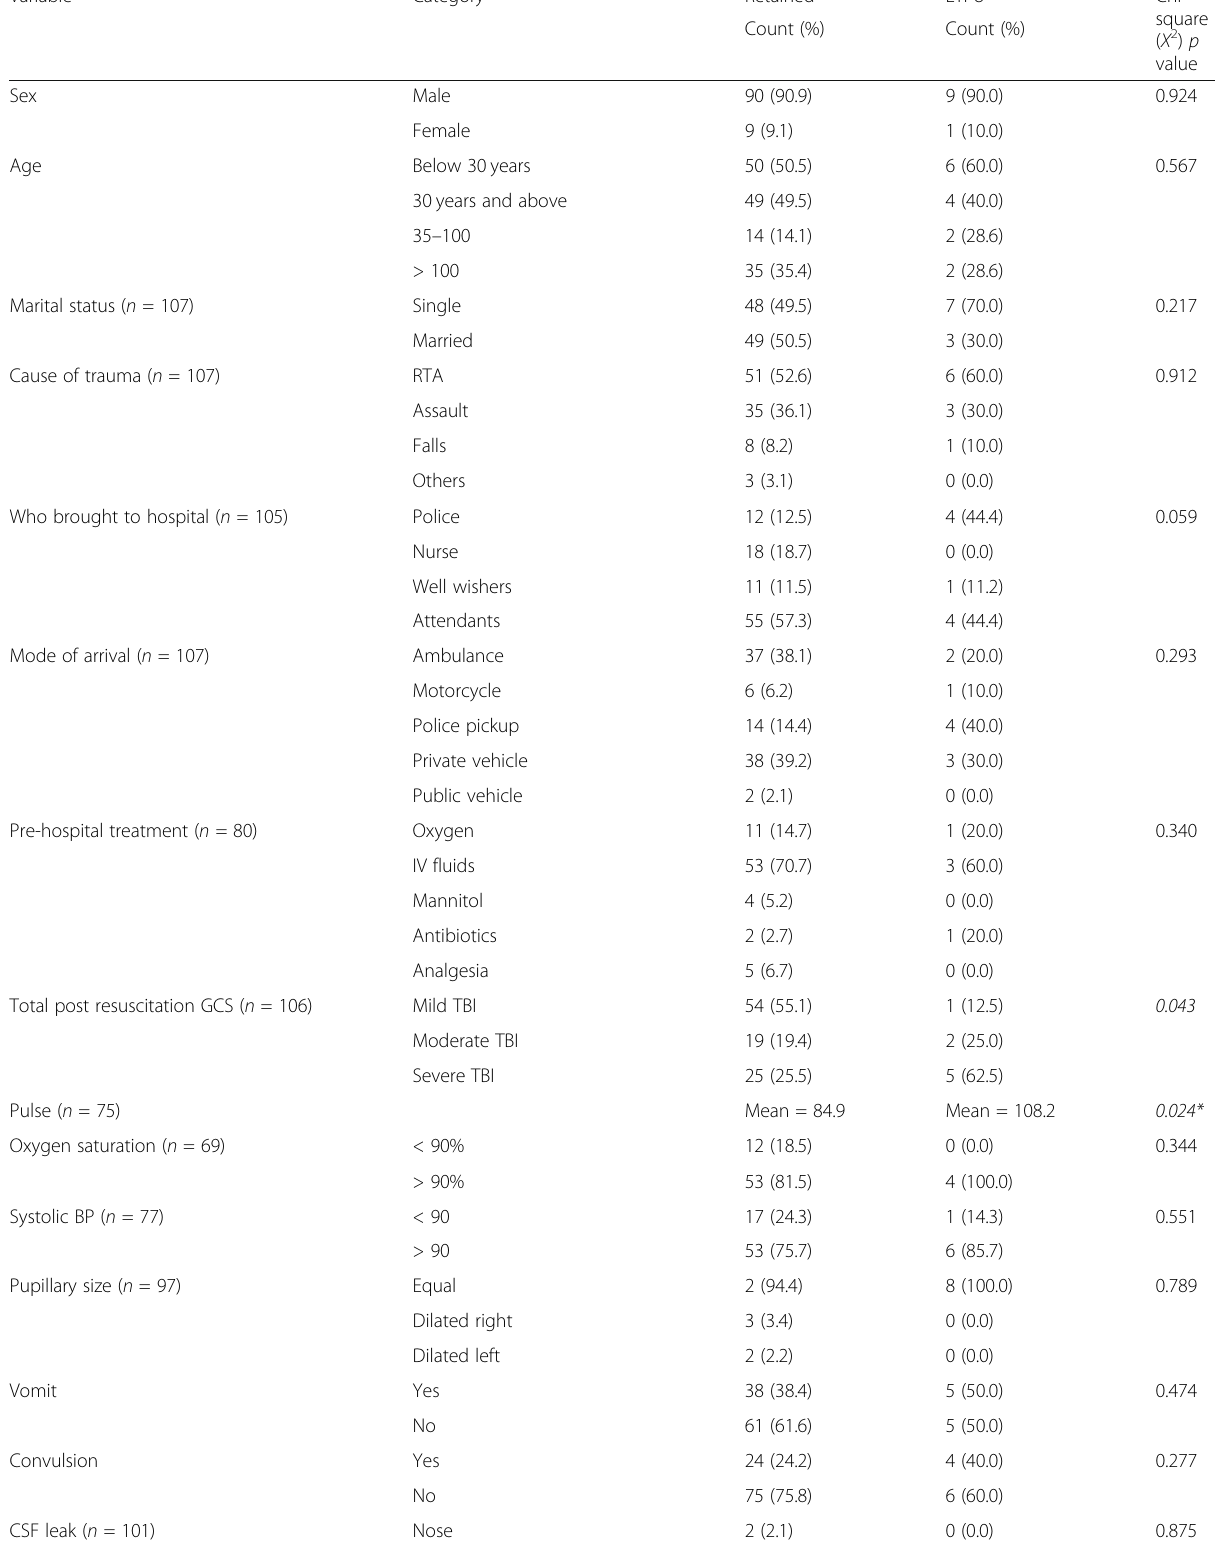
Table 4 Comparison of the baseline characteristics between retained and LTFU patients